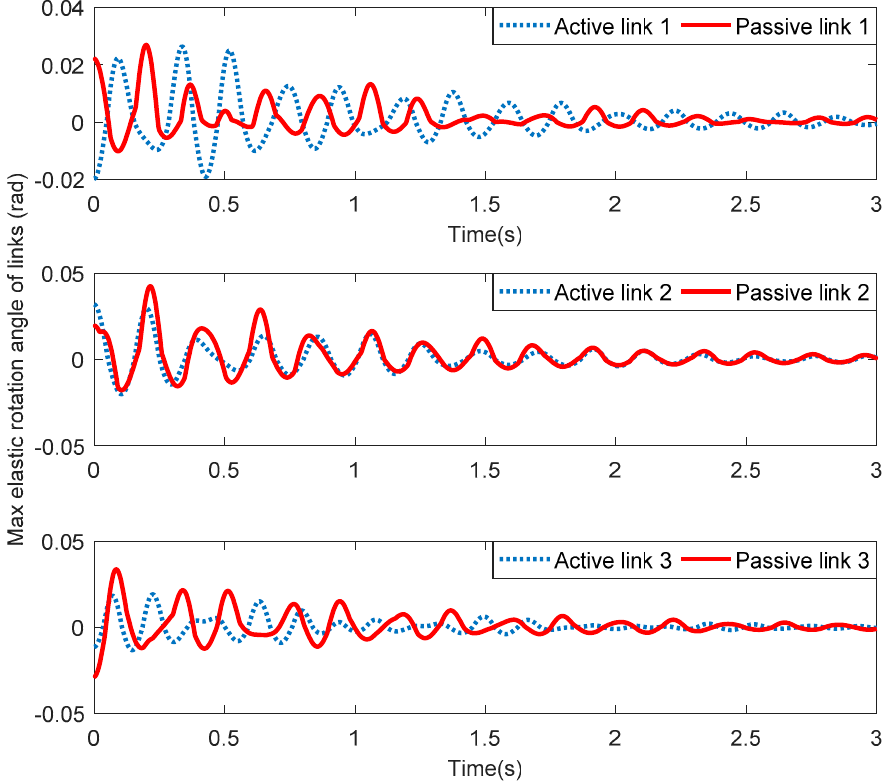
Figure 8. Maximum elastic rotation angles of active links and passive links.